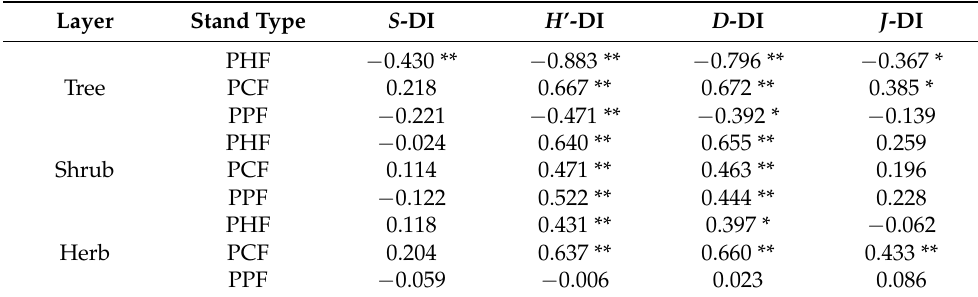
Table 7. The correlation coefficients between plant diversity indices and disease index of Diplodia tip blight in Pinus densiflora